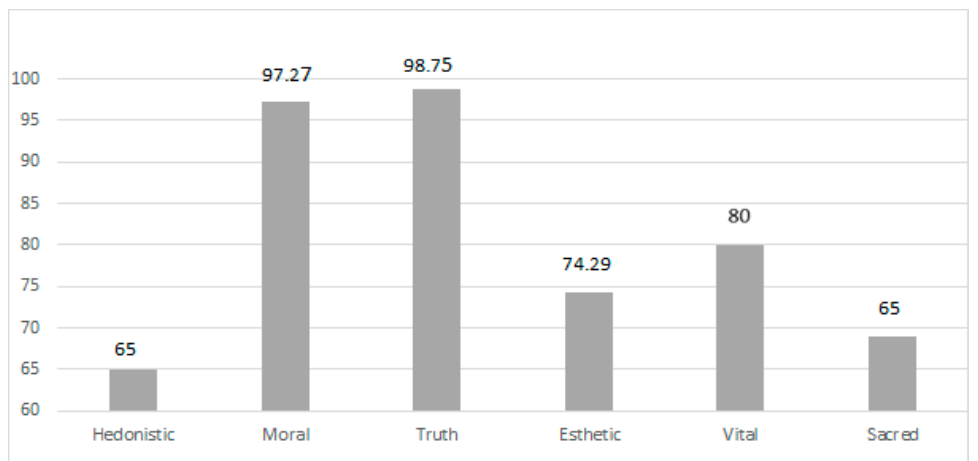
Figure 1. The hierarchy of values of the ultramarathon runner.